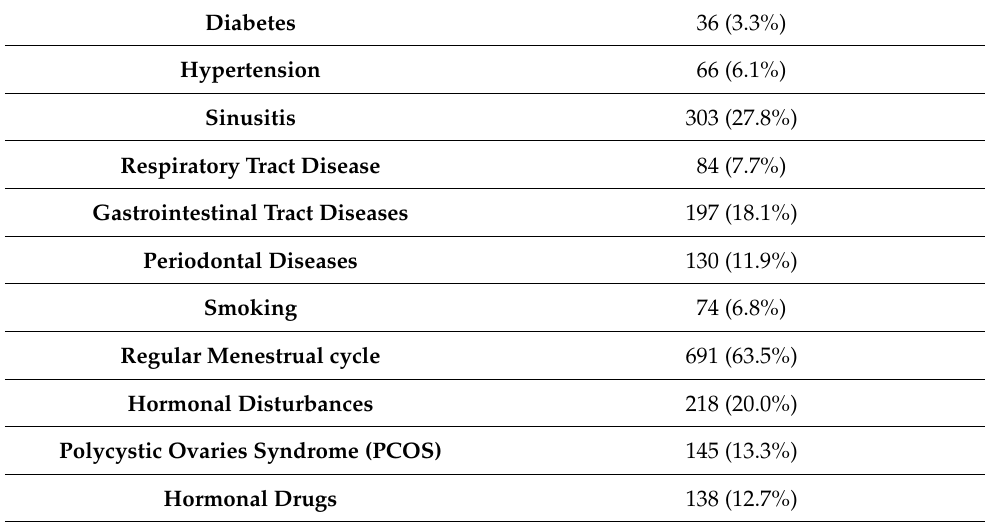
Table 2. Medical and dental